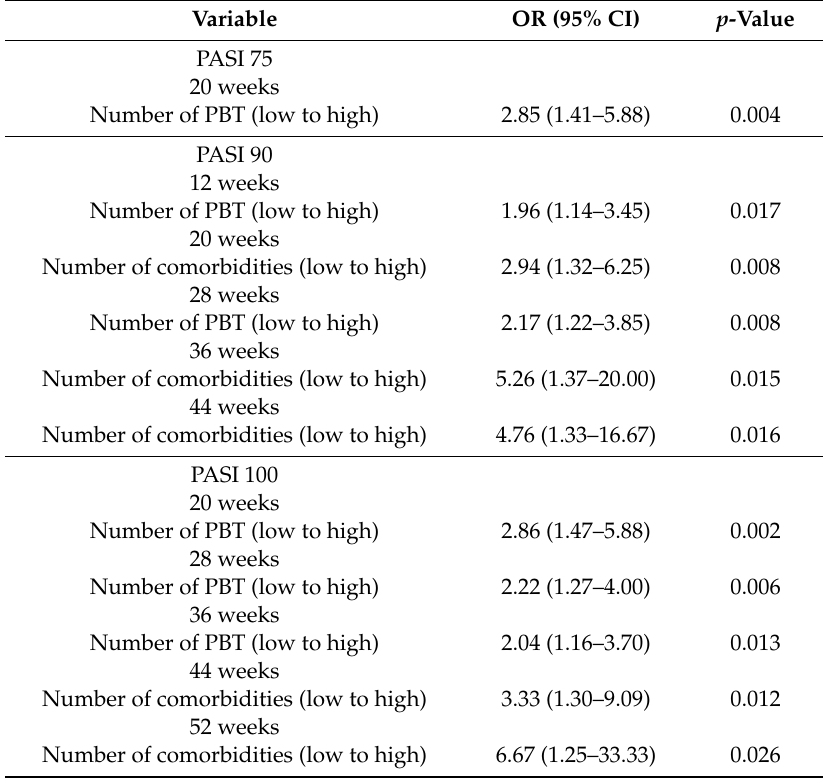
Table 5. Multivariate logistic regression analysis (stepwise analysis) of predictors of PASI 75, 90, and 100 response after treatment with